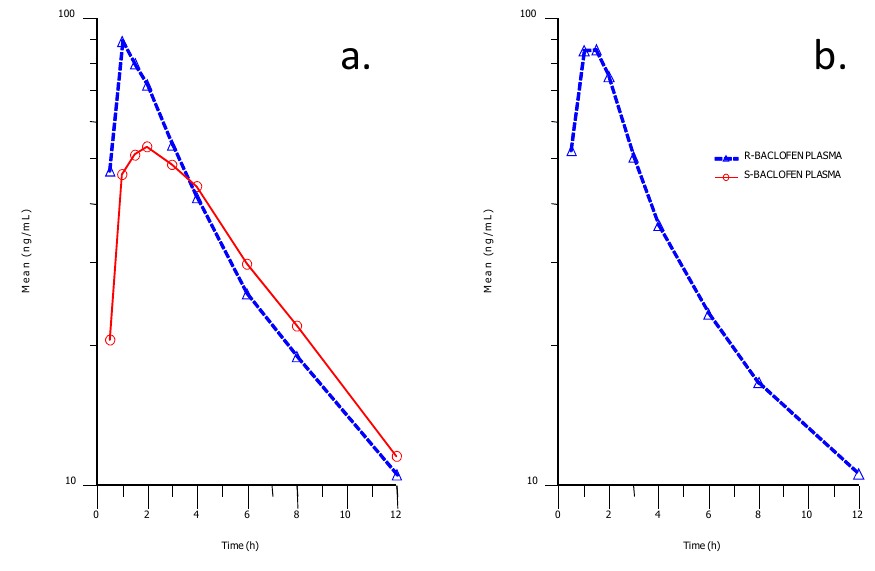
Figure 8. Phamacokinetic profiles in human plasma after an oral dose of baclofen ( a ) and STX209 ( b ). The solid profiles represent the plasma concentration of the S-enantiomer and the dashed lines represent the